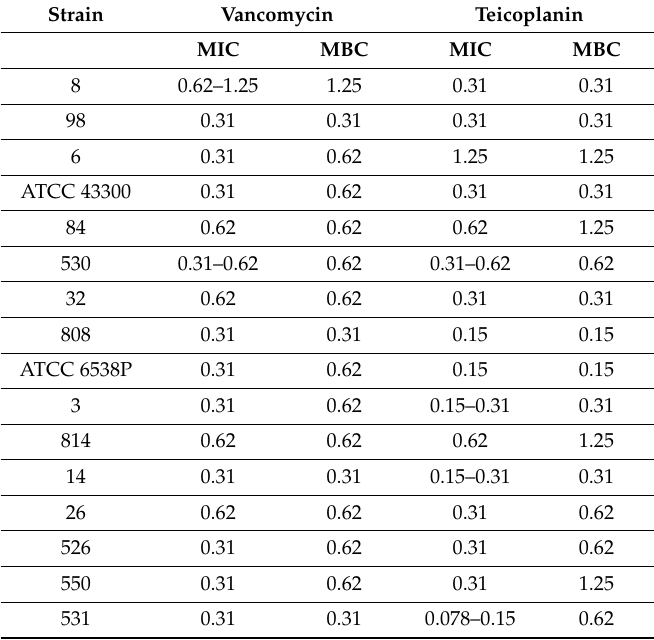
Table 4. MICs ( µ g mL − 1 ) and MBC ( µ g mL − 1 ) of vancomycin and teicoplanin against ATCC and clinical strains of S. aureus .